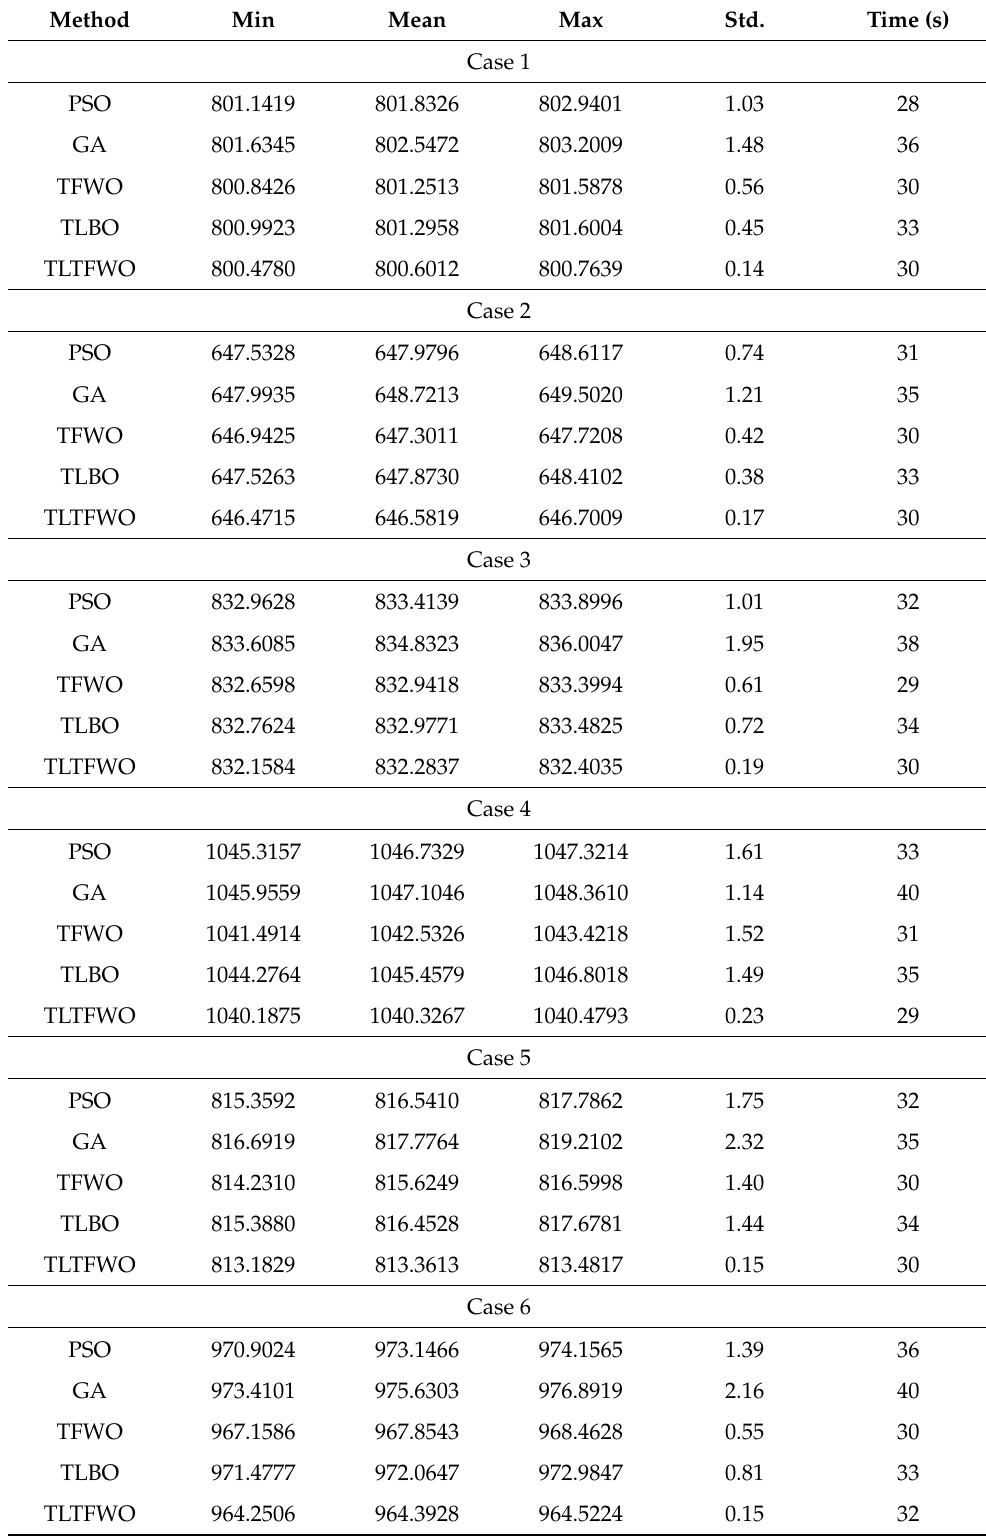
Table 13. Results of various parameters obtained by TTFWO, TFWO, and TLBO